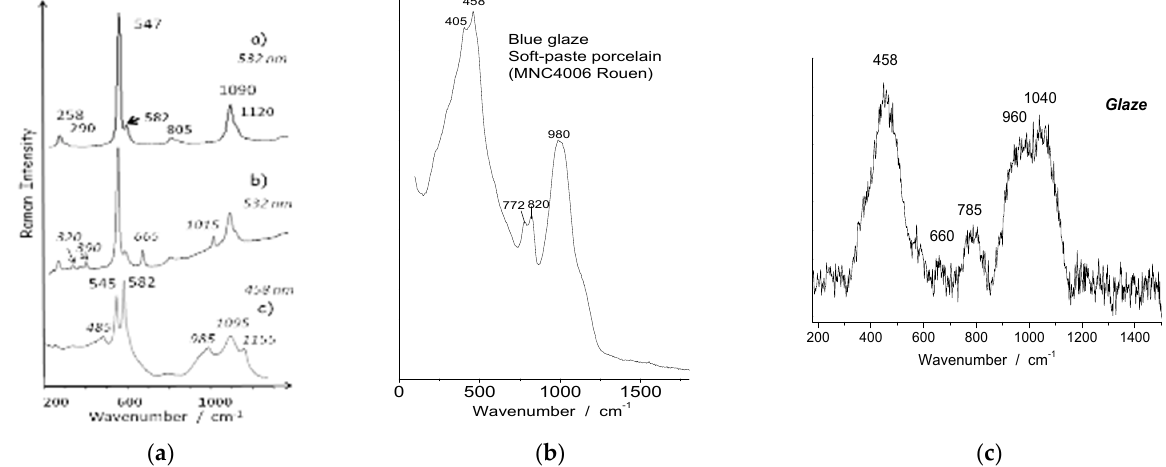
Figure 10. Examples of Raman spectra recorded with different laser excitations on lapis lazuli mineral (left, a ), and lapis-lazuli-containing enamel (left, b and c ) and on the glazes with a mobile 532 nm set-up, the blue areas of a European soft-paste porcelain (centre, b ) and a Vietnamese hard-paste porcelain (right, c ); the glaze of the oldest prepared (soft-paste) porcelain in Europe (Poterat Factory, Rouen circa 1680, Sèvres Cité de la Céramique collection) is lead-based with a characteristically strong 980 cm − 1 SiO 4 stretching peak. Note the flat background due to the light absorption by the blue glaze and high scattering at low wavenumber (the Boson peak is strong for a lead-based glass). The small 820 cm − 1 component is assigned to an As-based phase (see further). The signal intensity of the glaze of hard-paste Asian porcelain is much lower (potash-lime alumina-rich glaze) and the background should be subtracted to see the spectrum clearly; the SiO 4 stretching modes (900–1150 cm − 1 band) are shifted to higher wavenumbers due to the composition being richer in silica and alumina.